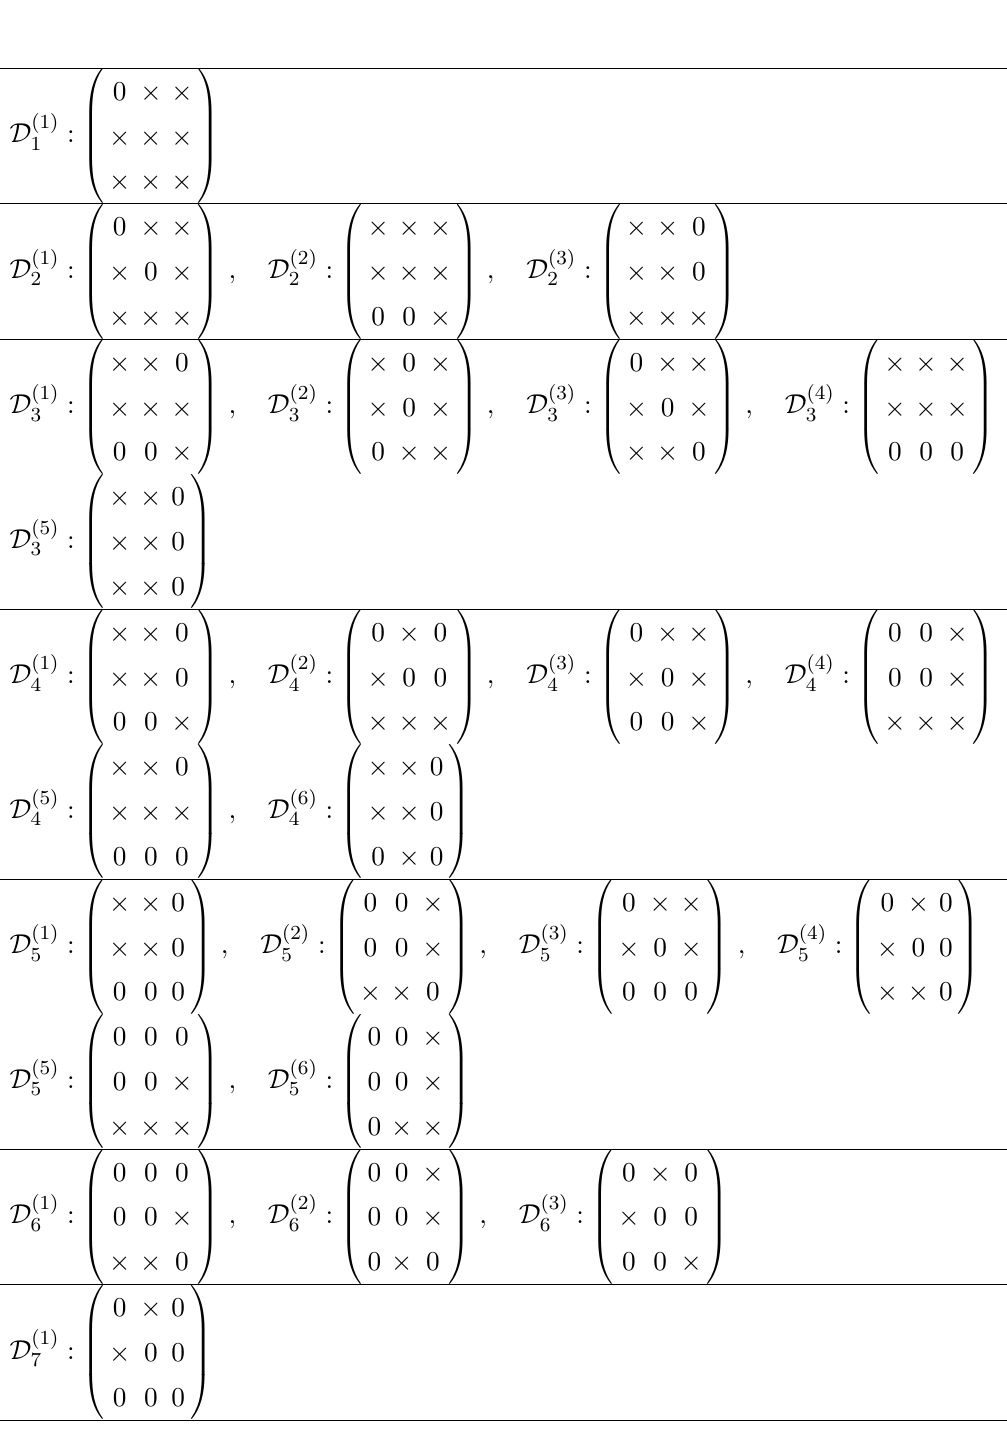
Table 3. Texture-zero patterns for the Dirac neutrino mass matrix M D which can be realised from T 0 modular symmetry, up to row and column